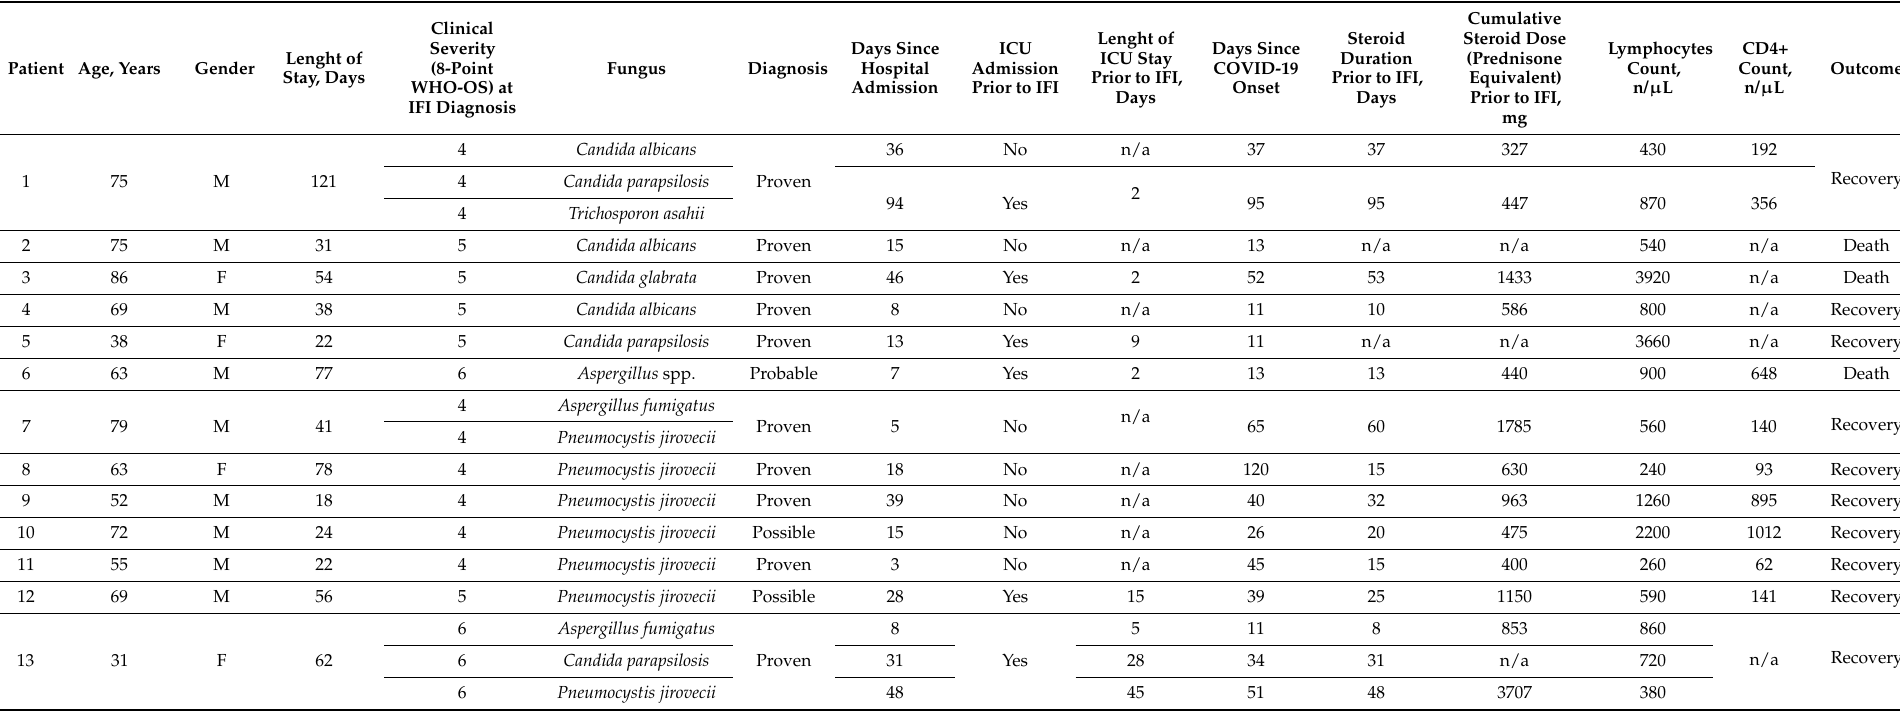
Table 1. Invasive fungal infections (IFIs) in patients with SARS-CoV-2 infection admitted to the Infectious Diseases Unit (IDU) of the University Hospital “Federico II” of Naples from the 8 March 2020 to the 1 July